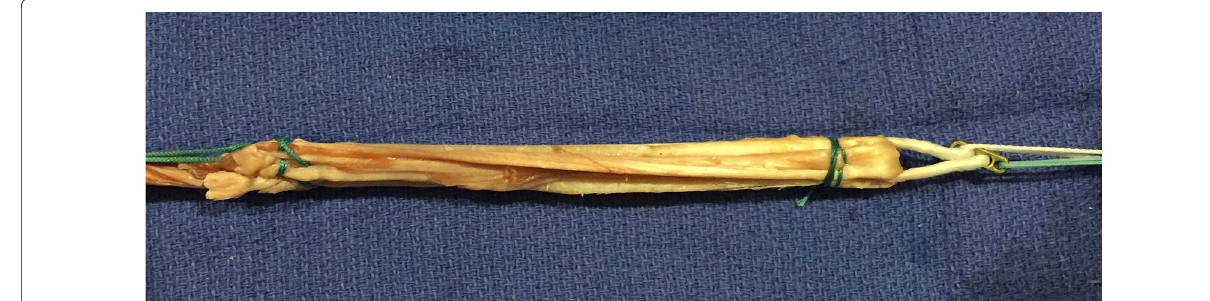
Fig. 1 Number of cycles to failure for individual specimens